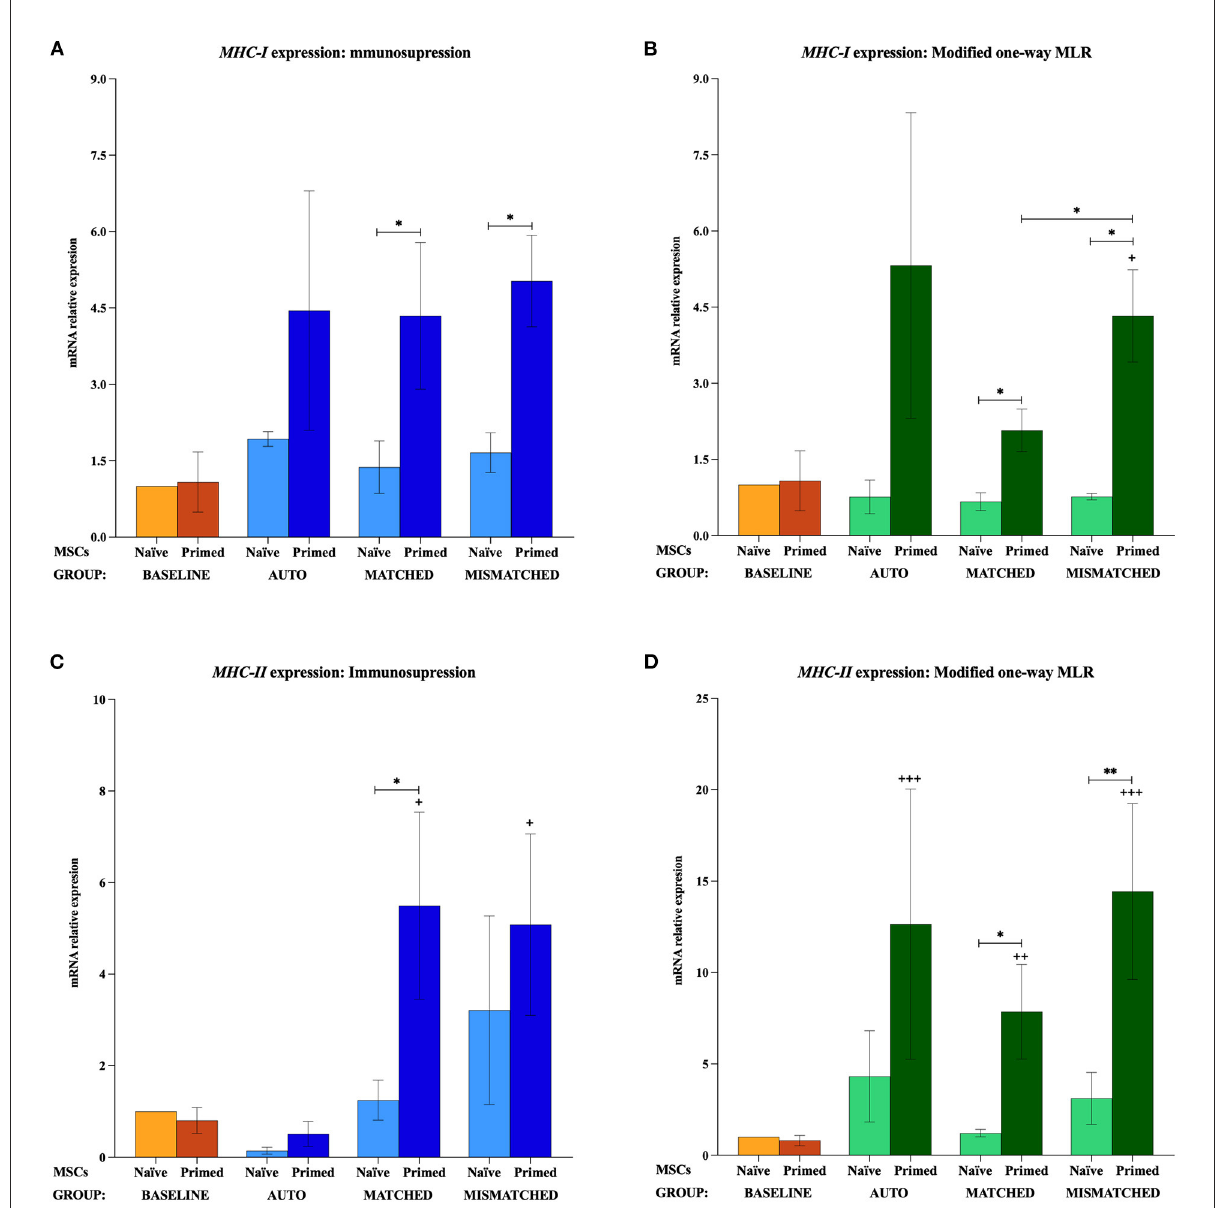
FIGURE5 Changes in major histocompatibility complex ( MHC )- I and MHC- II expression by equine mesenchymal stem cells (MSCs) in the different scenarios. (A) MHC-I and (C) MHC-II mRNA relative expression before (baseline; orange bars) and after equine MSC-naive (light blue bars) and MSC-primed (dark blue bars) were exposed in vitro to phytohemagglutinin (PHA)-activated peripheral blood lymphocytes (PBLs) (immunosuppression assays). (B) MHC-I and (D) MHC-II mRNA relative expression before (baseline; orange bars) and after MSC-naive (light green bars) and MSC-primed (dark green bars) were exposed in vitro to resting PBLs [modified one-way mixed lymphocyte reaction (MLR) assays]. Co-cultures of MSCs and PBLs were autologous ( n = 3) or allogeneic, matched ( n = 8), or mismatched ( n = 7) for the MHC. Data from the D1 donor could not be included in the MHC-I analysis because of the lack of reference values since this gene was not expressed at the baseline. Changes in gene expression are represented as mean ± S.E.M of the relative mRNA expression, using baseline MSC-naive as reference sample (light orange bar, value 1). Significant differences compared with the baseline MSC-primed (dark orange bar) are represented by a cross ( + ) above the corresponding bar ( + p < 0.05; ++ p < 0.01; +++ p < 0.001). Significant differences between experimental conditions are represented by a squared line with an asterisk ( * p < 0.05; ** p < 0.01).